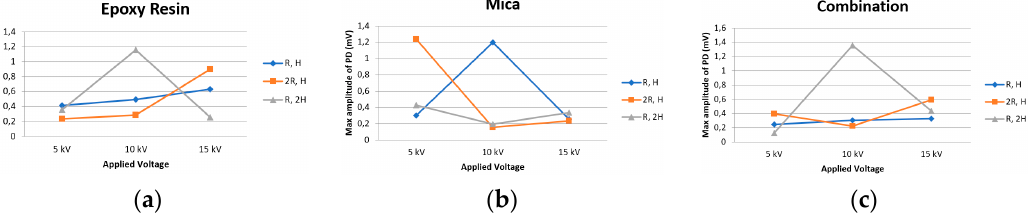
Figure 33. Maximum amplitude of PD for the 1st model for ER ( a ), mica ( b ), and combination ( c ).